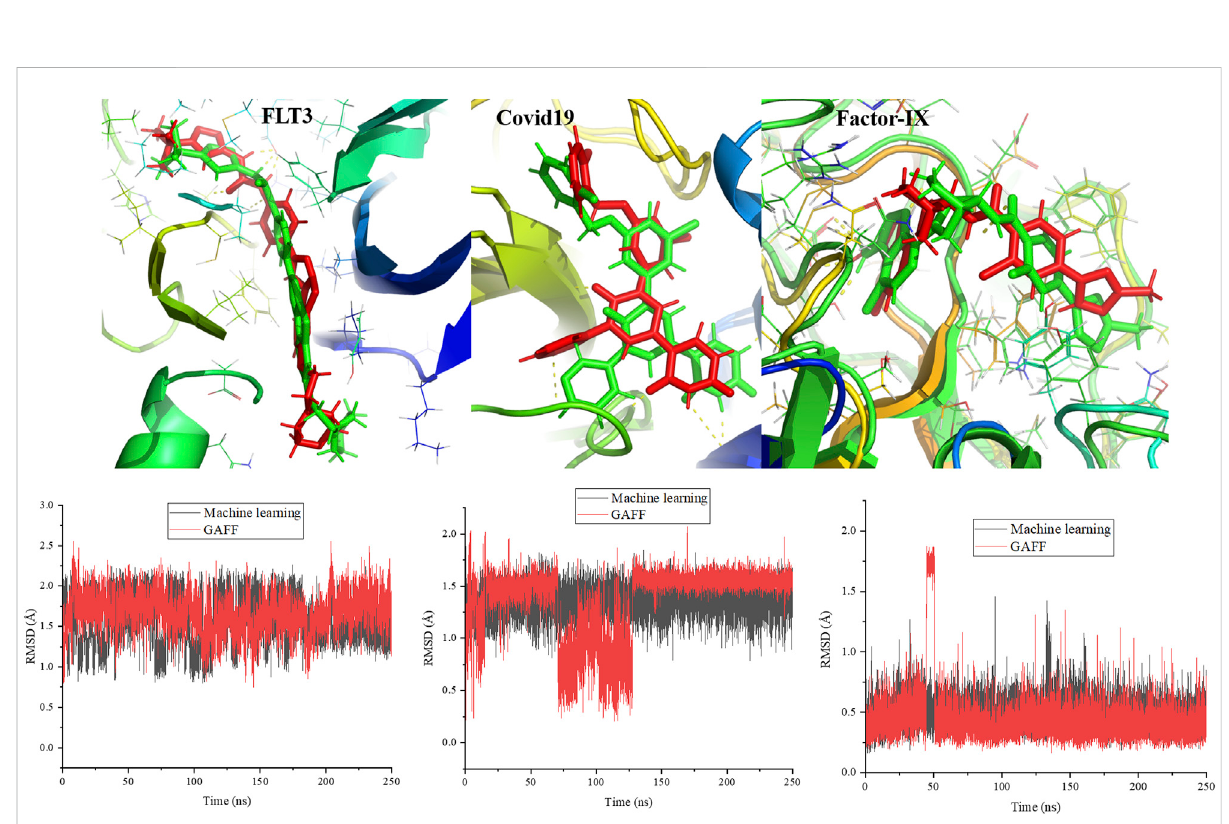
FIGURE 12 Simulated structures of proteins related to kinase, covid19 and factor-IX at 250 ns are compared between machine learning force fi eld and GAFF. The calculated RMSD for the ligands in protein-ligand complex throughout the simulation. Ligand represent in green and red color corresponds to machine learning and GAFF,